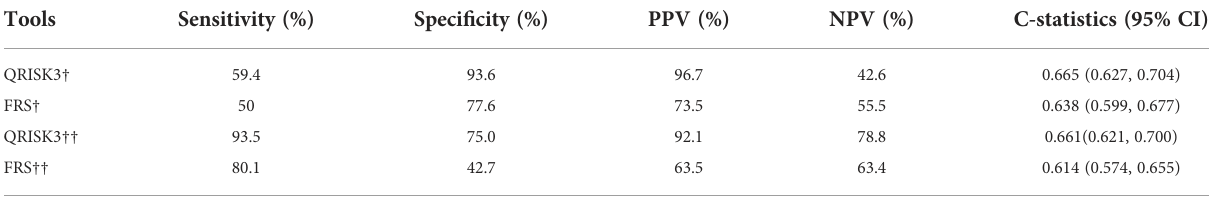
TABLE 6 Sensitivity, speci fi city, PPV, NPV and C-statistics of QRISK3 and FRS (patients with loss to follow-up were classi fi ed as the CVD group).